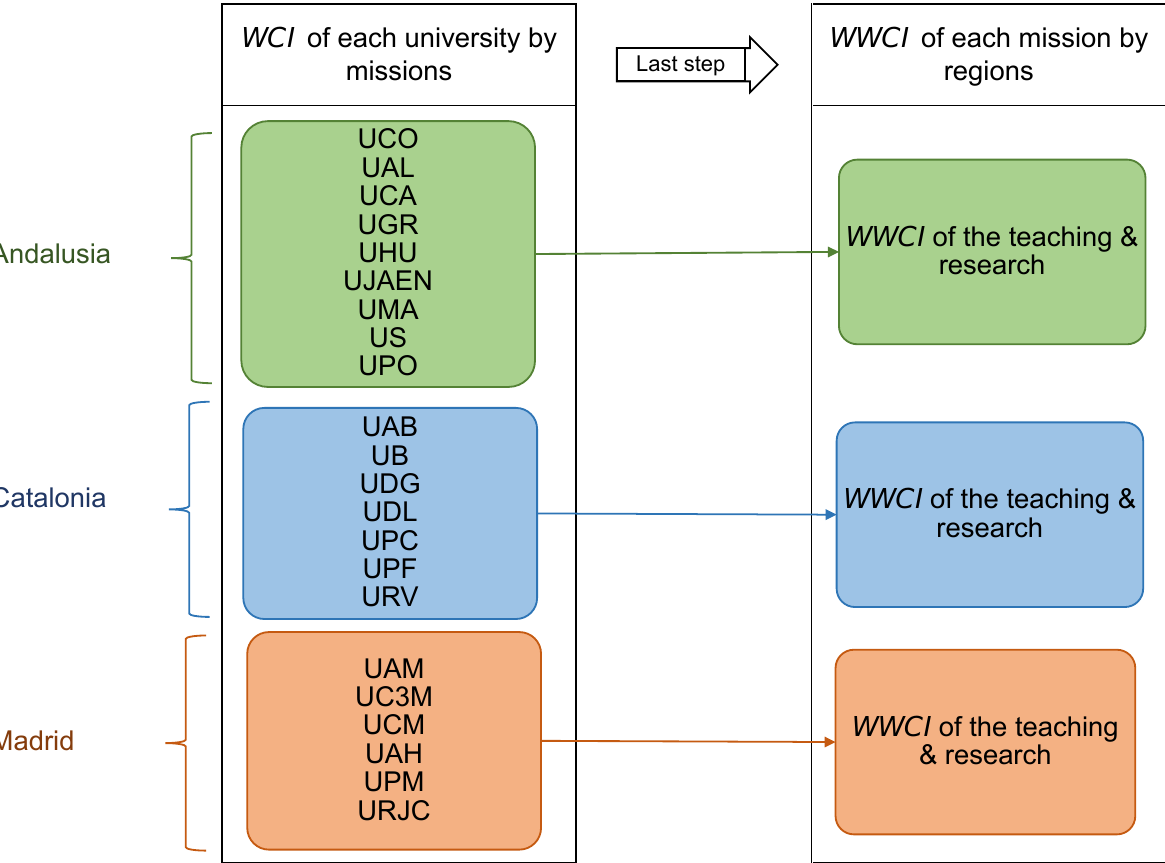
Figure 9. Steps for constructing the WWCI by regions for each academic